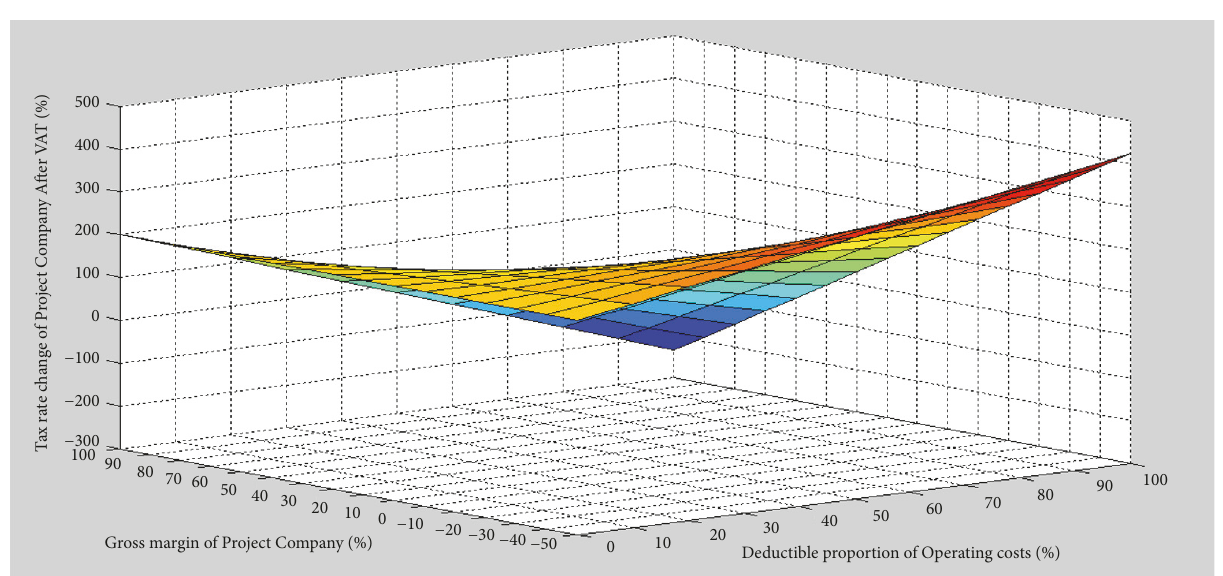
Figure 3: The relationship among 𝑝, 𝑘 , and 𝑚